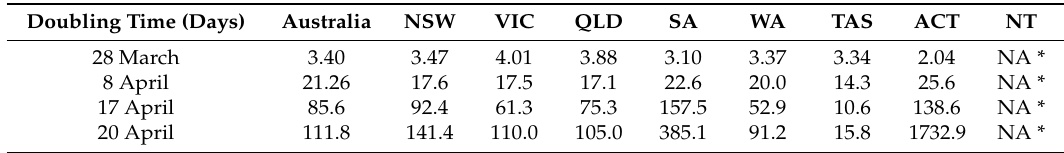
Table 2. Doubling rate of COVID-19 in Australia and by states and territories. Doubling rates calculated from the growth rate of the last 10 days. Data retrieved from the Australian Government Department of Health (2020) [9]. Last updated on 20 April 2020. Doubling Time (Days)